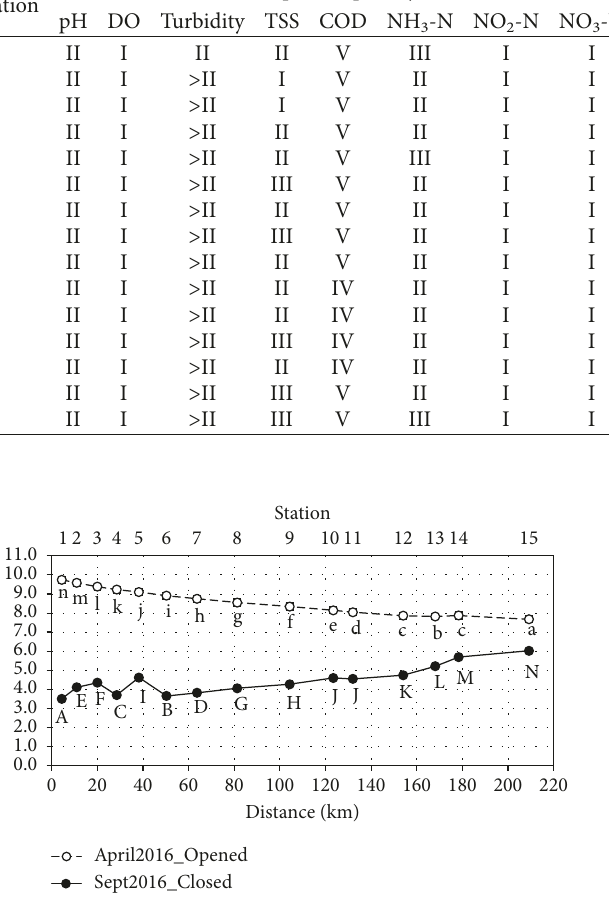
Table 4: Classification of water quality parameters for all stations during opened and closed spillways according to NWQS [14]. Opened spillway Station